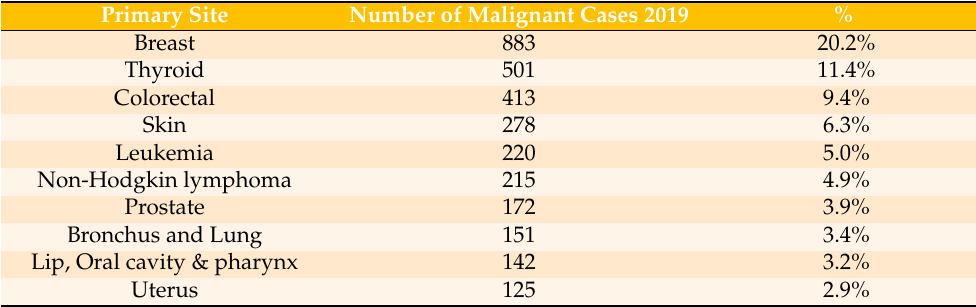
Table 1. Top ten most common malignant primary sites among the UAE population, 2019.